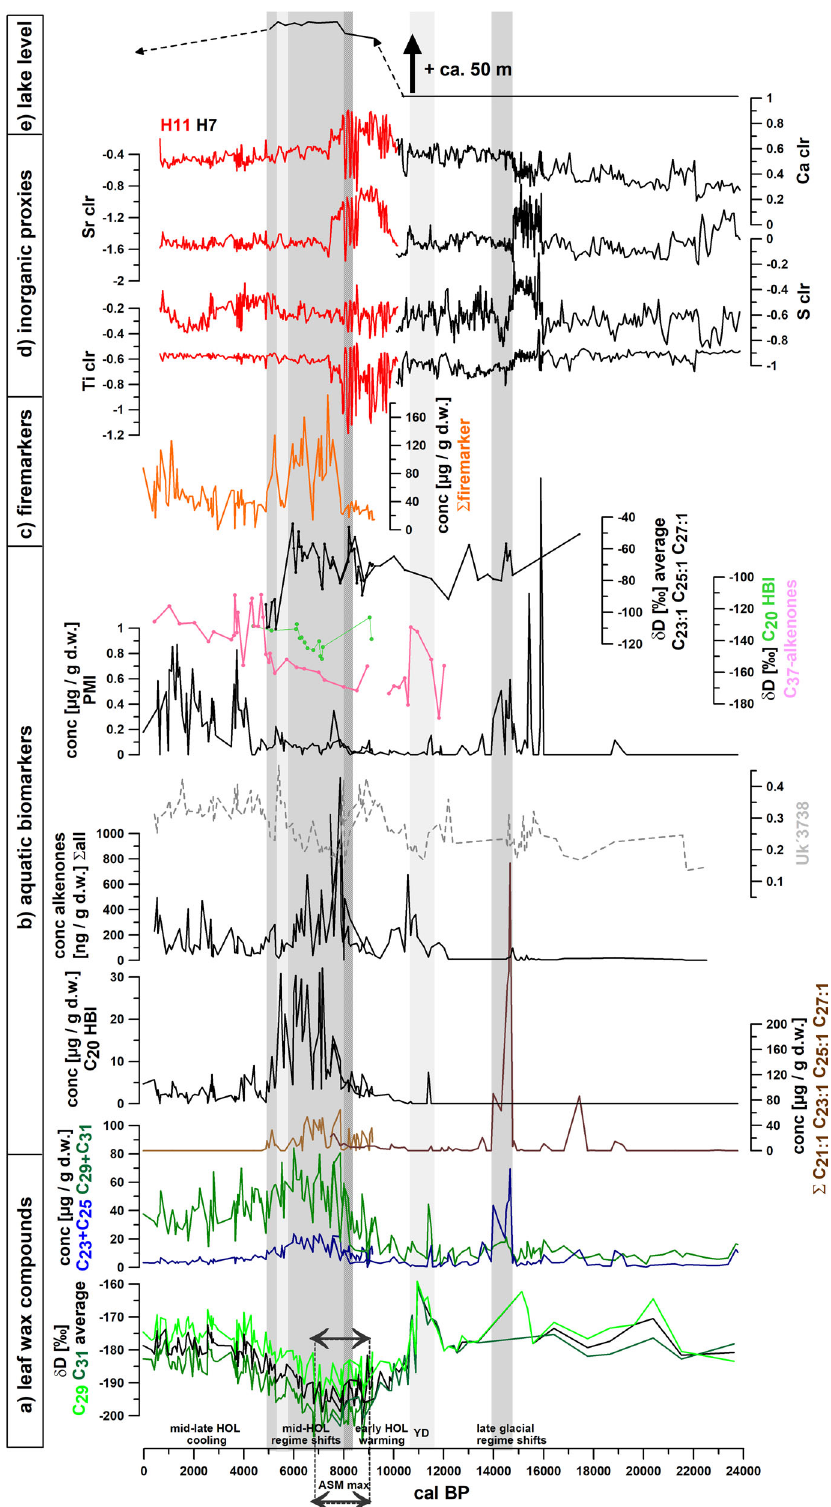
Fig. 2 Summary of measured proxy parameters in cores H7 and H11 (overlap 7.4 − 9.1 kyrs BP). a δ D values and concentrations of mid- and long-chain n - alkanes. Arrows (ASM) indicate the maximum strength of the summer monsoon over Asia. b Concentrations of aquatic biomarkers (C 20 -HBI, alkenones, n - alkenes) and of microbial derived PMI; alkenone index (Uk ´ 3738 ) and C 37 -alkenone δ D values. c Concentrations of fi remarkers ( Σ M, L, G). d Titanium, sulfur, strontium, and calcium contents from XRF-scanning 22,23 . e Lake level reconstructed from ostracod assemblages 9 . Dark dashed interval 8.4 − 8.0 kyrs BP indicates mass fl ow layer. Light and medium grey shaded areas mark episodes of late glacial and mid-Holocene regime shifts within the aquatic